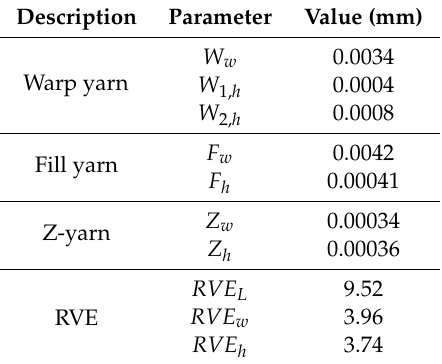
Figure 4. The geometry of 3D-FRC along with parameters: ( a ) optical images of the fabricated panel; ( b ) schematic diagram showing weave parameters of 3D-FRC. Table 1. Geometric parameters of